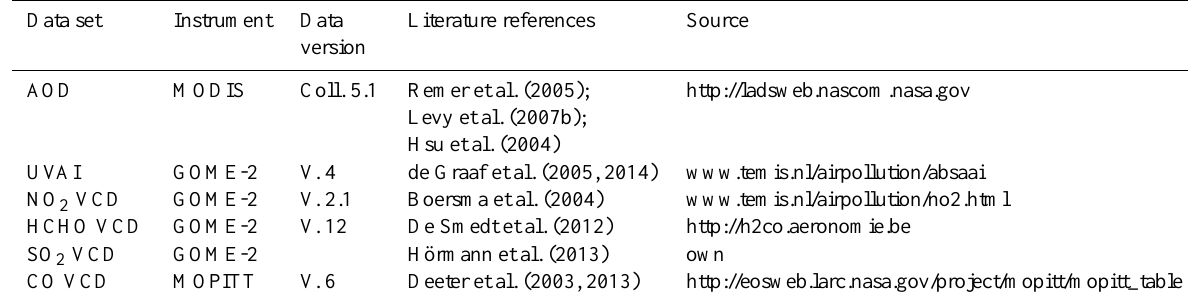
Table 1. Data sets that are used as input to GACA, with appropriate literature references and websites. Data